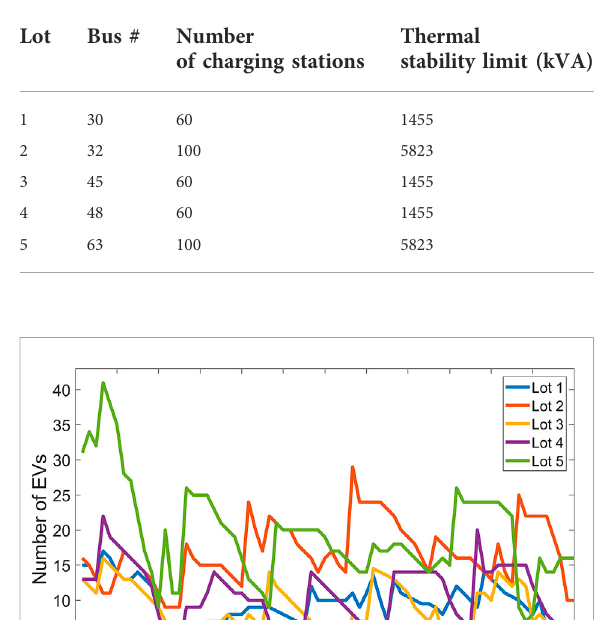
TABLE 3 Details of parking lot and charging pile in distribution network system.